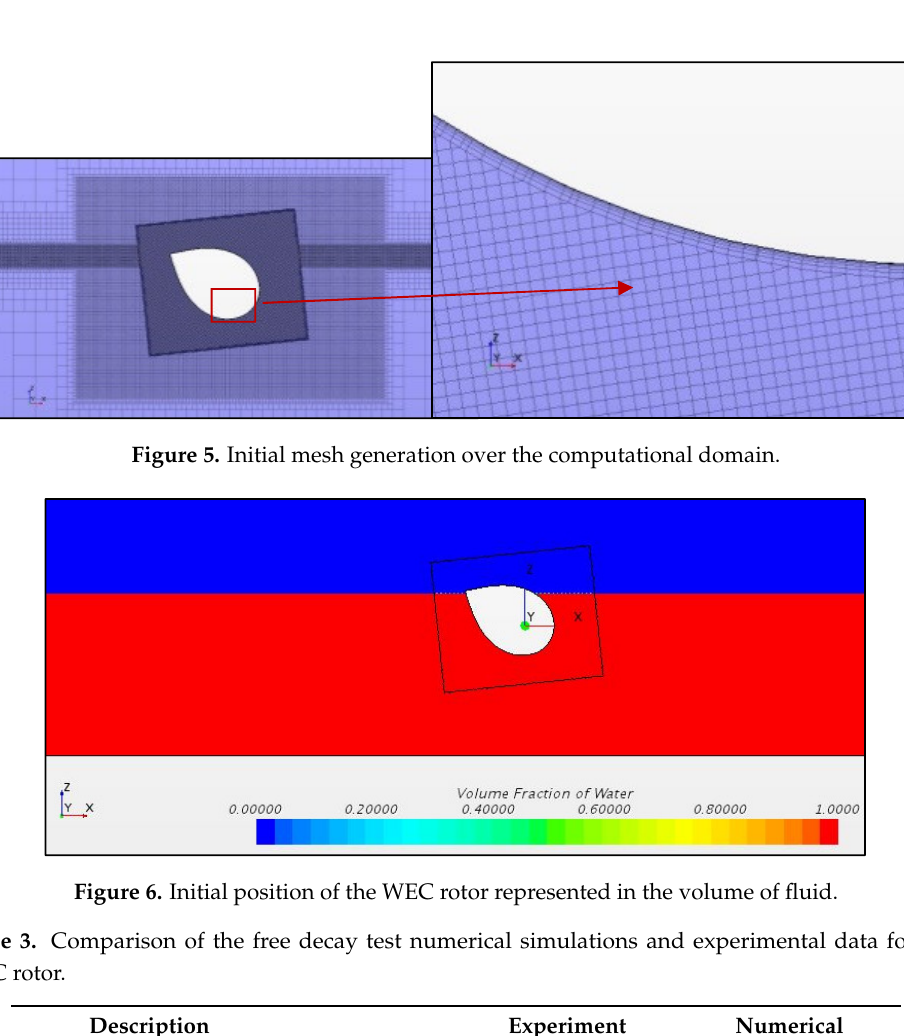
Figure 6. Initial position of the WEC rotor represented in the volume of fluid. Table 3. Comparison of the free decay test numerical simulations and experimental data for the WEC rotor.